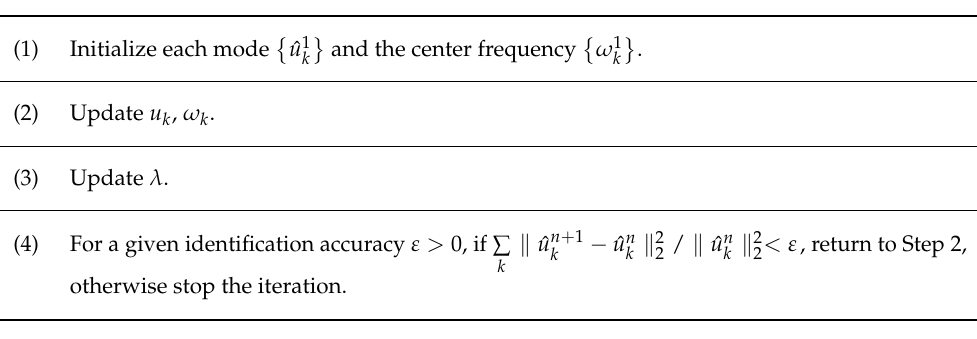
Table 1. The implementation process of